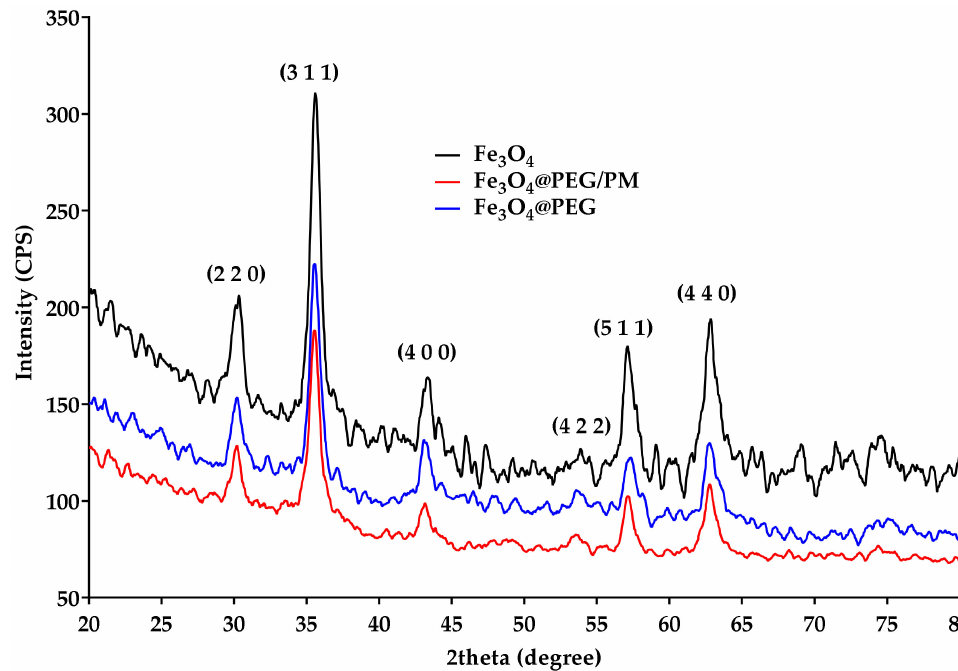
Figure 1. X-ray diffractogram of Fe 3 O 4 , Fe 3 O 4 @PEG, and Fe 3 O 4